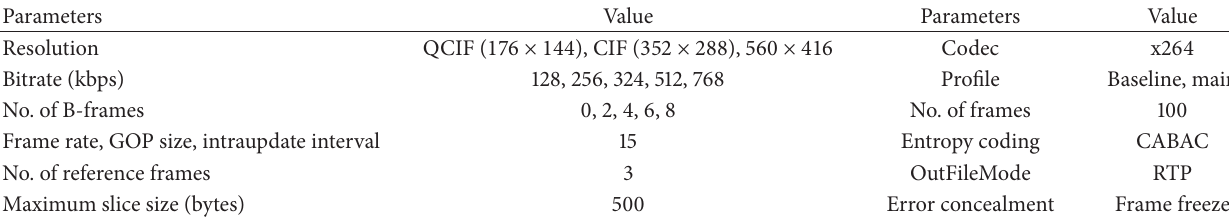
Table 1: Encoding